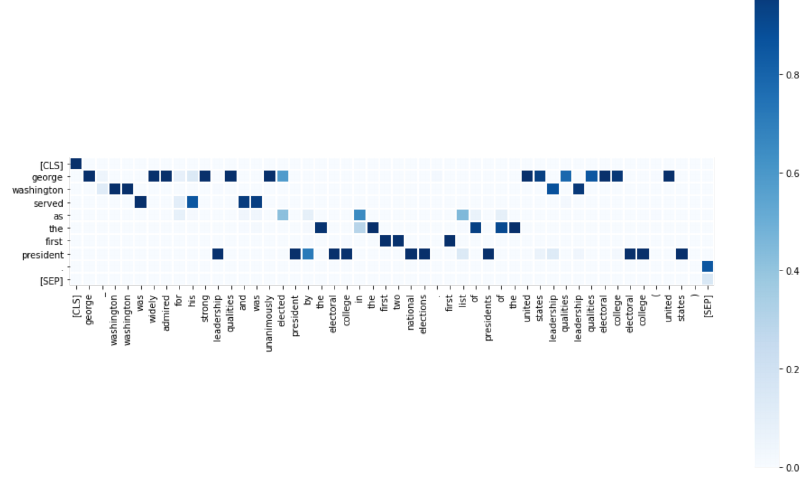
Figure 9. Attention map obtained from the model. Corresponds to Figure